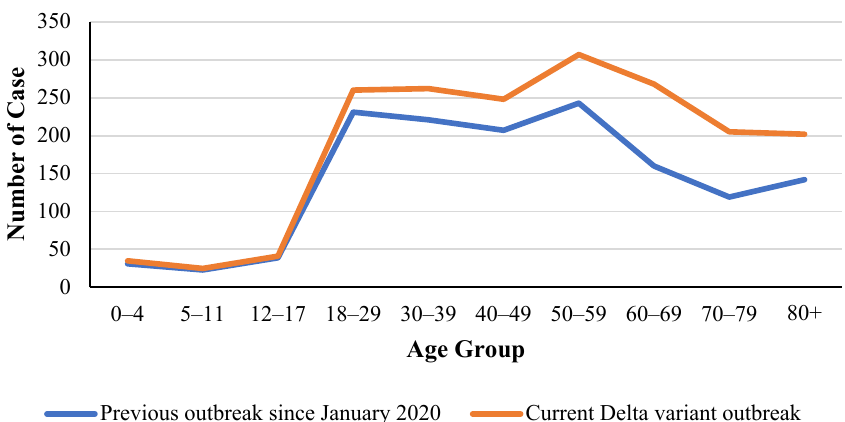
Figure 12. Hospitalized cases comparison by age group between the current Delta and previous outbreaks in Australia [66].